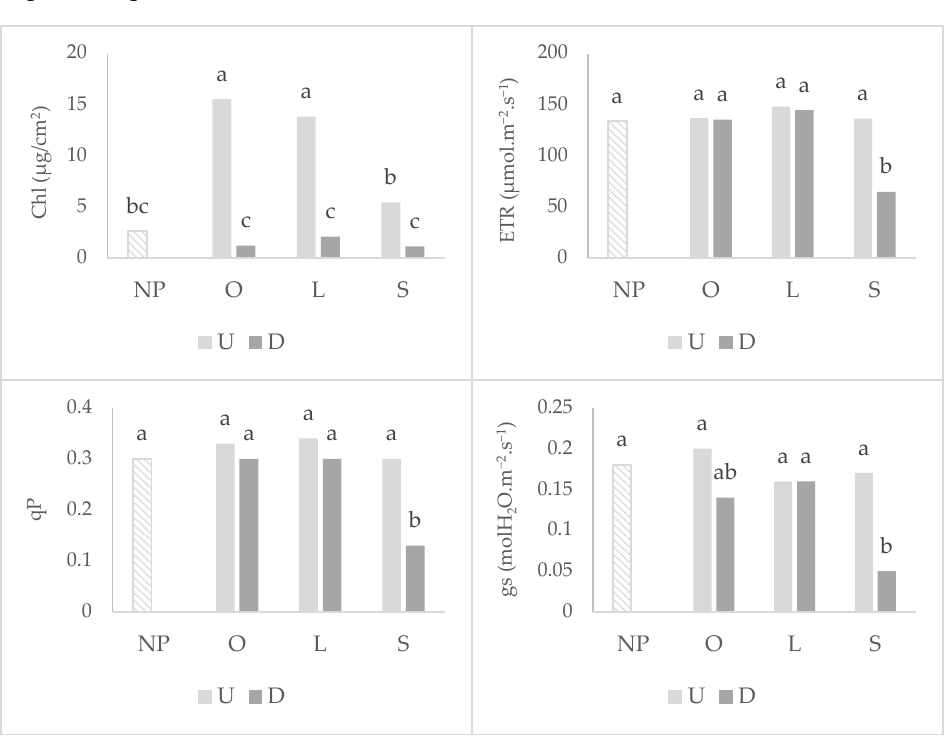
Figure 2. Comparison of wheat growth 21 days after planting. OD: after O. compressus under dis- turbed treatment; OU: after O. compressus under undisturbed treatment; LD: after L. rigidum under disturbed treatment; LU: after L. rigidum under undisturbed treatment. no previous plant exhibited the lower A and Fv/Fm (Table 1).